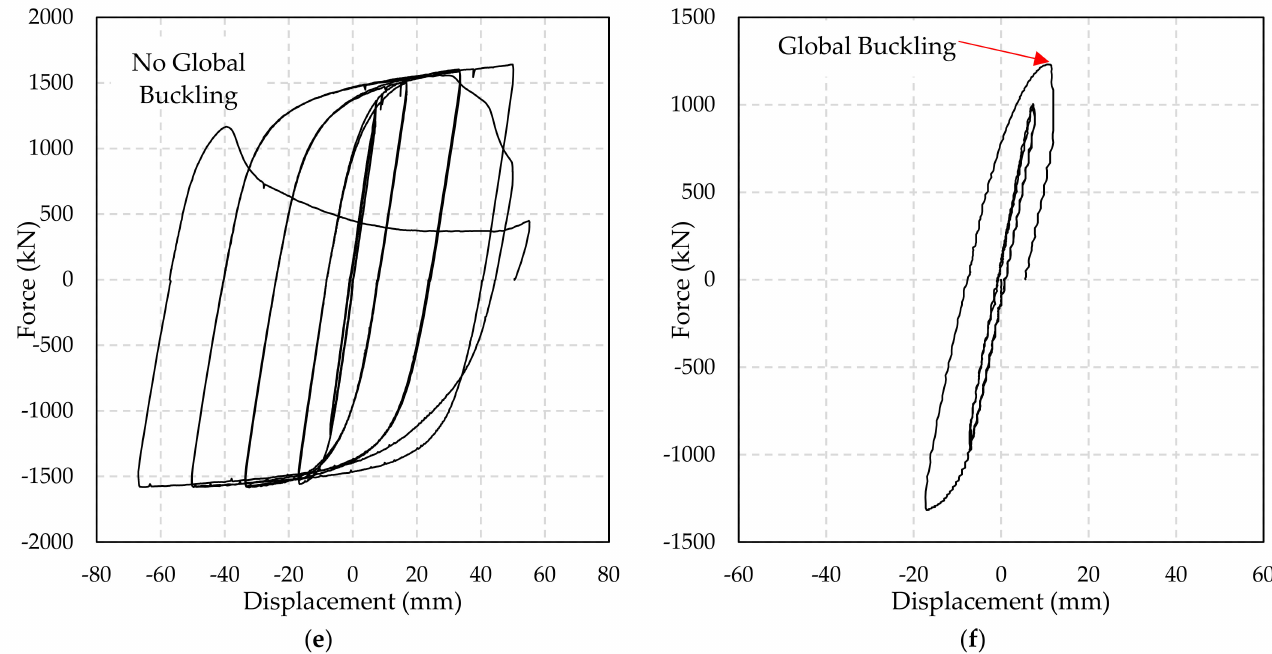
Figure 7. Hysteretic response of circular specimens: ( a ) C216 t8–C267 t6-S ; ( b ) C216 t8–C267 t6-B1 ; ( c ) C216 t8–C267 t6-B2 ; ( d ) C216 t8–C267 t6-B3 ; ( e ) C216 t6–C267 t6-B ; ( f ) C165 t7–C216 t6-B